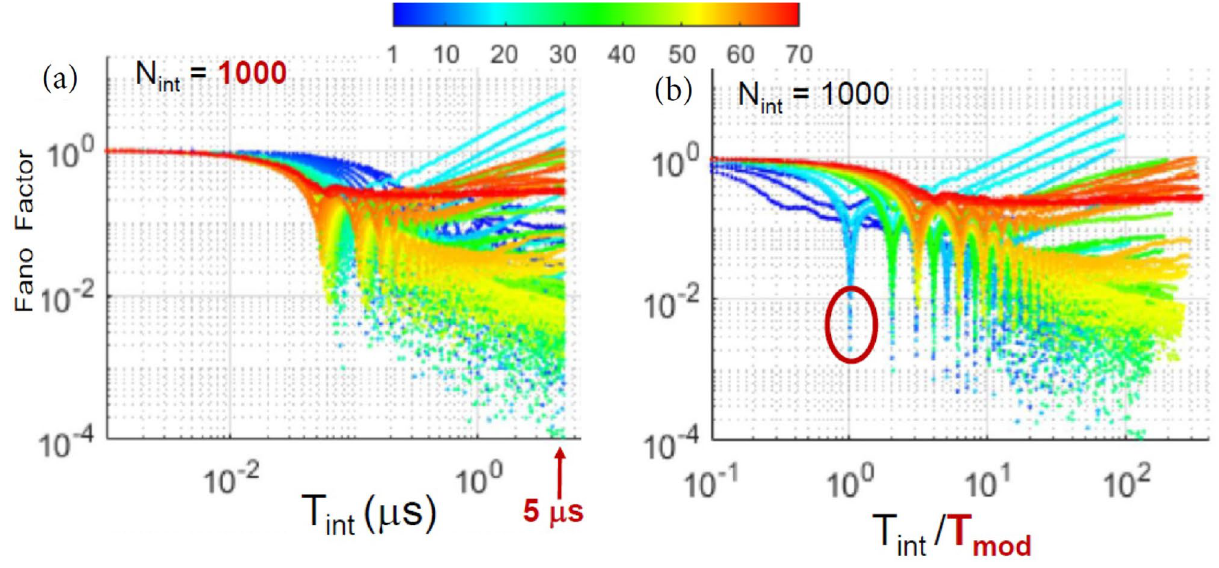
Figure 4. ( a ) Fano factor versus the duration of the counting interval, T int . The modulation is pulsed, I dc = 26 mA, and the color code indicates the modulation frequency in MHz. ( b ) F versus T int normalized